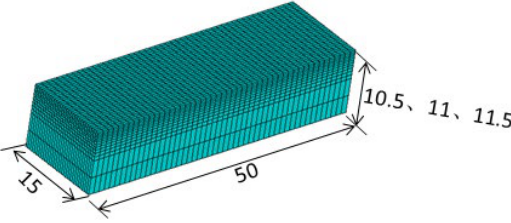
Figure 2. Finite element mesh model.